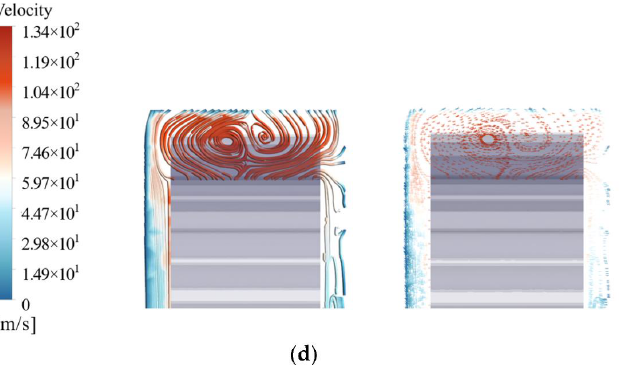
Figure 11. The streamline and velocity vector between the teeth: ( a ) Baffle configuration 1; ( b ) Baffle configuration 2; ( c ) Baffle configuration 3; ( d ) Baffle configuration 4.